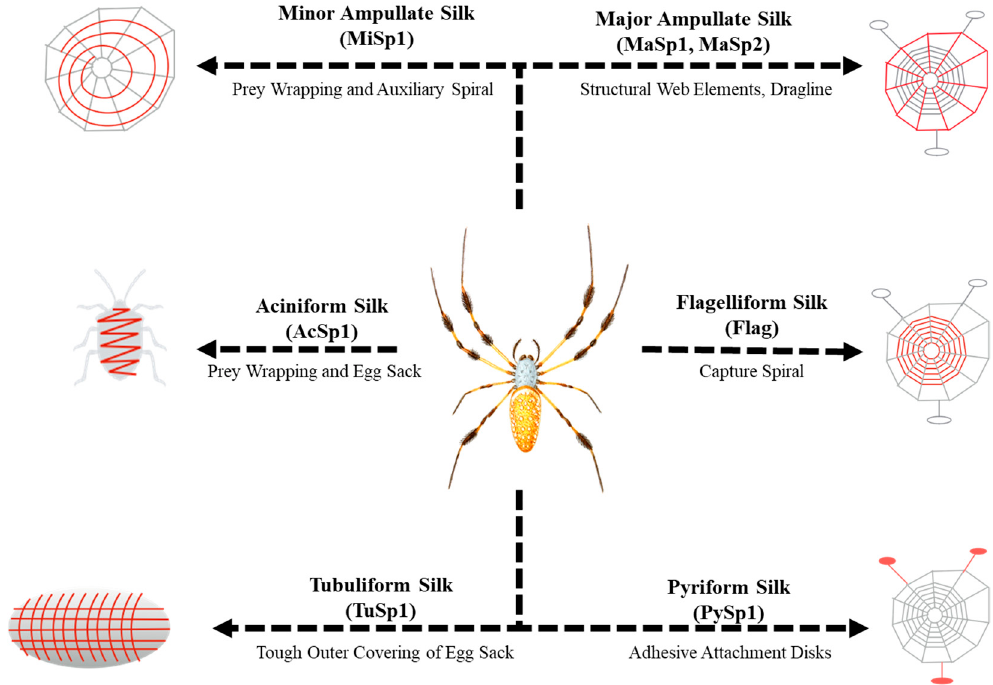
Figure 1. Summary figure of gene function and properties of spider silk. The function of each of the silks (shown in red) for the orb-weave specie Nephila clavipes are described.